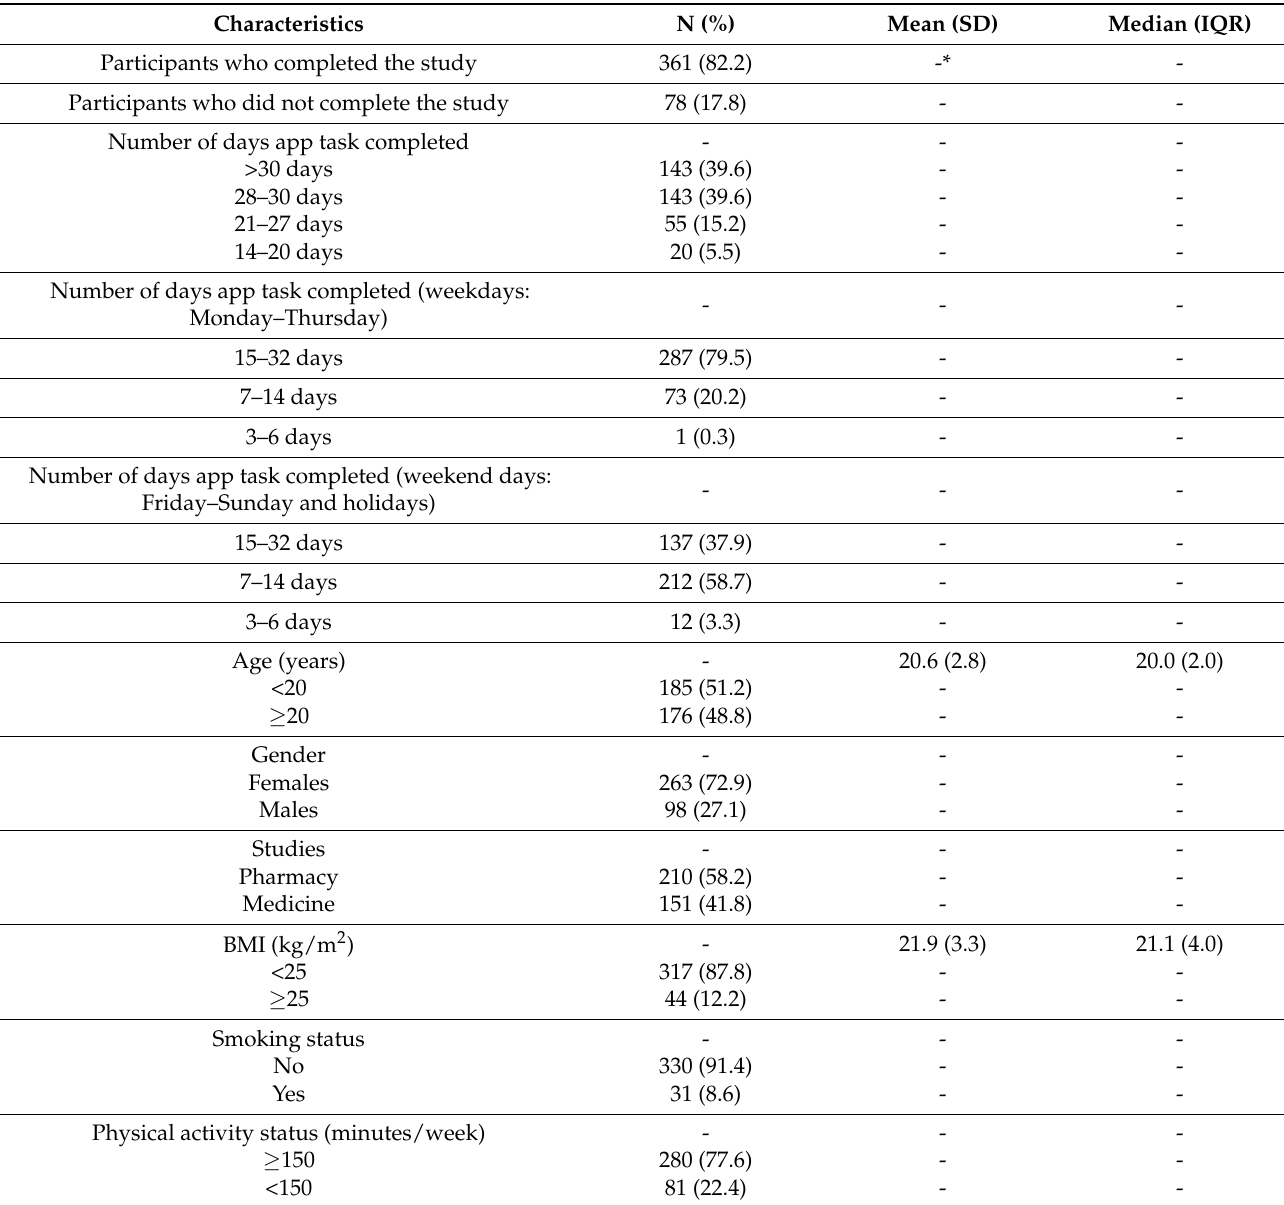
Table 2. Characteristics of study